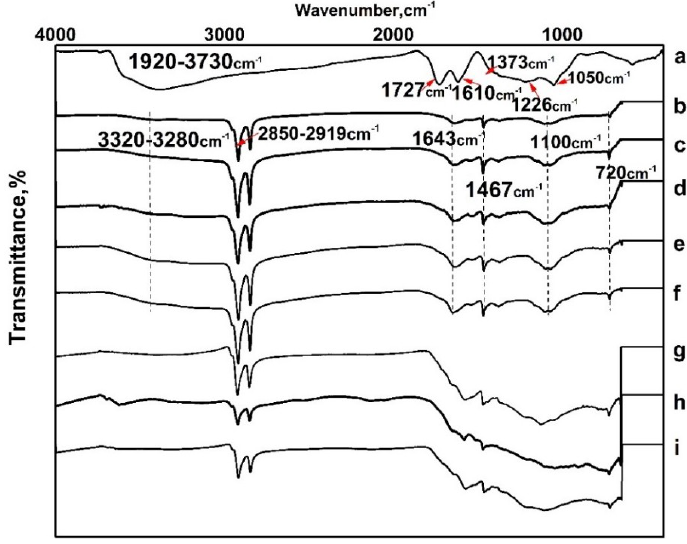
Figure 1. FTIR spectra of GO and ORGOs ( a : GO; b : ORGO at 35 °C, 0.5 h; c : ORGO at 35 °C, 5 h; d : ORGO at 50 °C, 0.5 h; e : ORGO at 50 °C, 5 h; f : ORGO at 80 °C, 0.5 h; g : ORGO at 80 °C, 5 h; h : ORGO at 120 °C, 0.5 h; i : ORGO at 120 °C, 5 h).